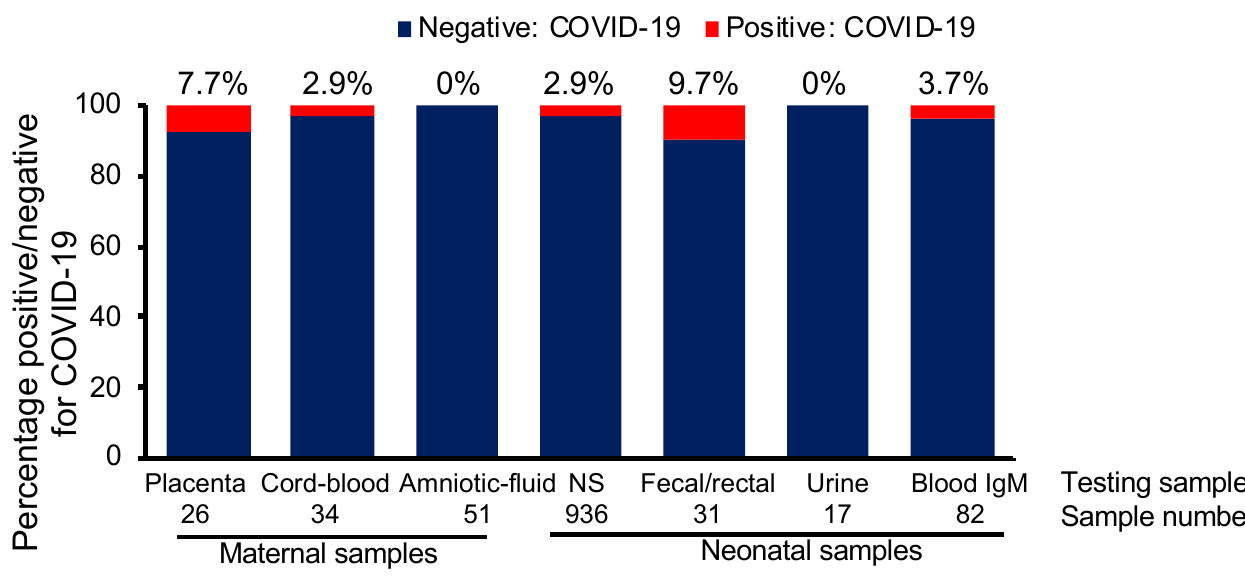
Figure 3. Vertical transmission rate of COVID-19 to neonates based on different testing sites and meta-data analysis of 38 studies. IgM, immunoglobulin M; NP, nasopharyngeal; COVID-19, coronavirus disease 2019.